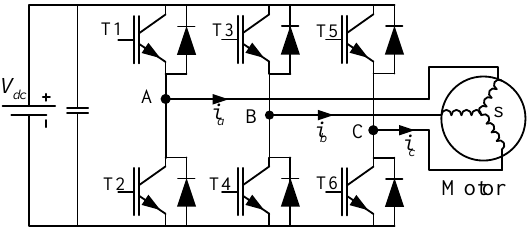
Figure 1. Schematic diagram of three-phase inverter system.